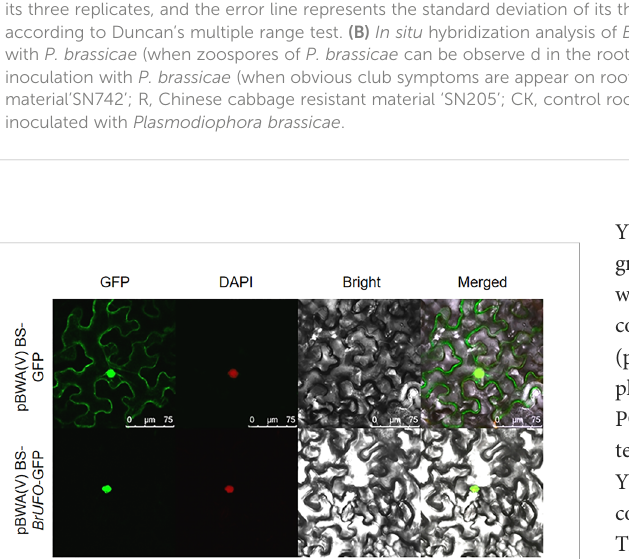
FIGURE 2 Subcellular localization of BrUFO. The green fl uorescence signal is from GFP; the red fl uorescence signal is from DAPI; the yellow fl uorescence signal is the result of superposition of green and red fl uorescence signals.